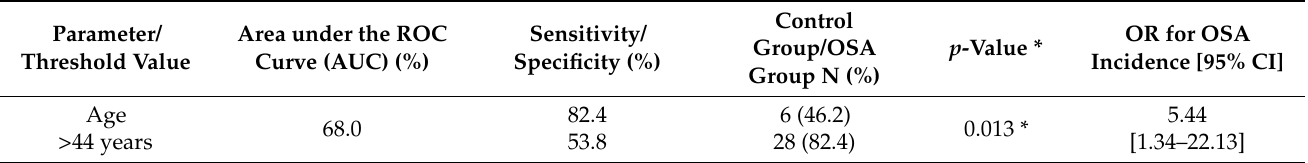
Table 2. ROC test for the predicted values of respondent ages and the distribution of its characteristics.